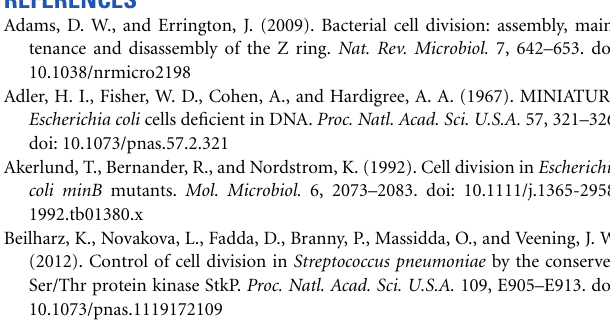
FIGURE 5 | Model of DivIVA dynamics in B. subtilis . During cytokinesis DivIVA rings at constricting septa collapse into foci/patches (Eswaramoorthy et al., 2011). Exponentially growing B. subtilis cells redeploy at least a fraction of DivIVA molecules from old division sites (cell poles) to nascent septa (broken white lines). Only in non-dividing cells DivIVA is clearly seen as accumulation at both cell